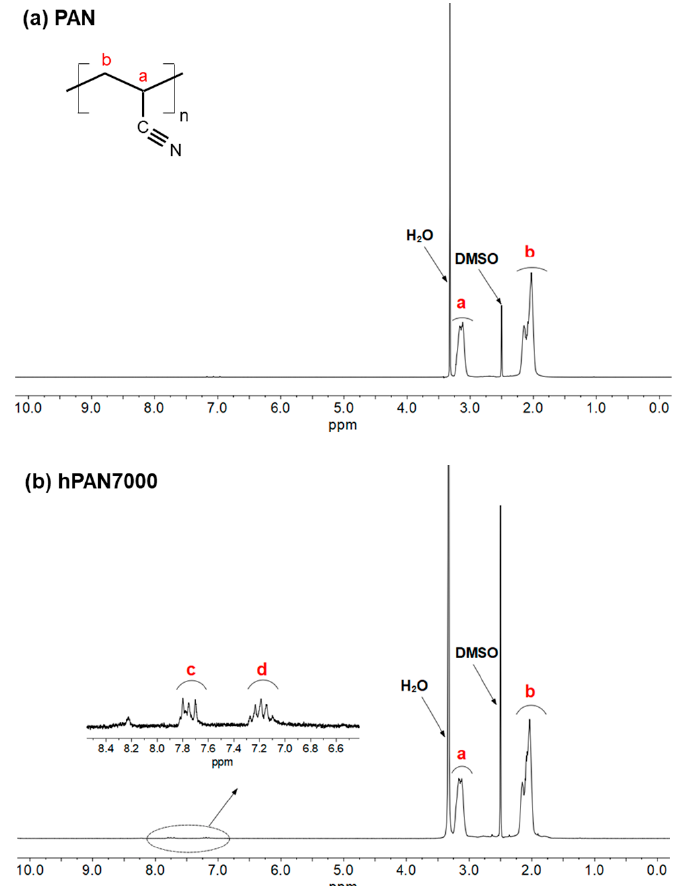
Figure 5. 1H NMR spectra of ( a ) unmodified PAN, and ( b ) hPAN7000, in DMSO-d6.